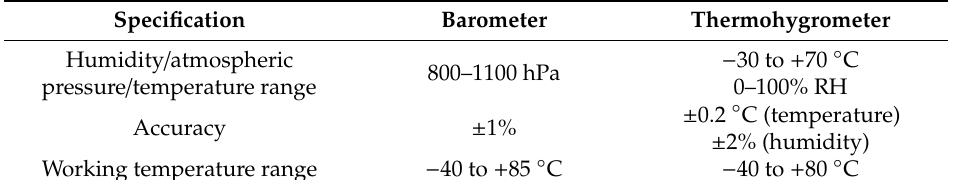
Table 2. Basic barometer and thermohygrometer specifications.